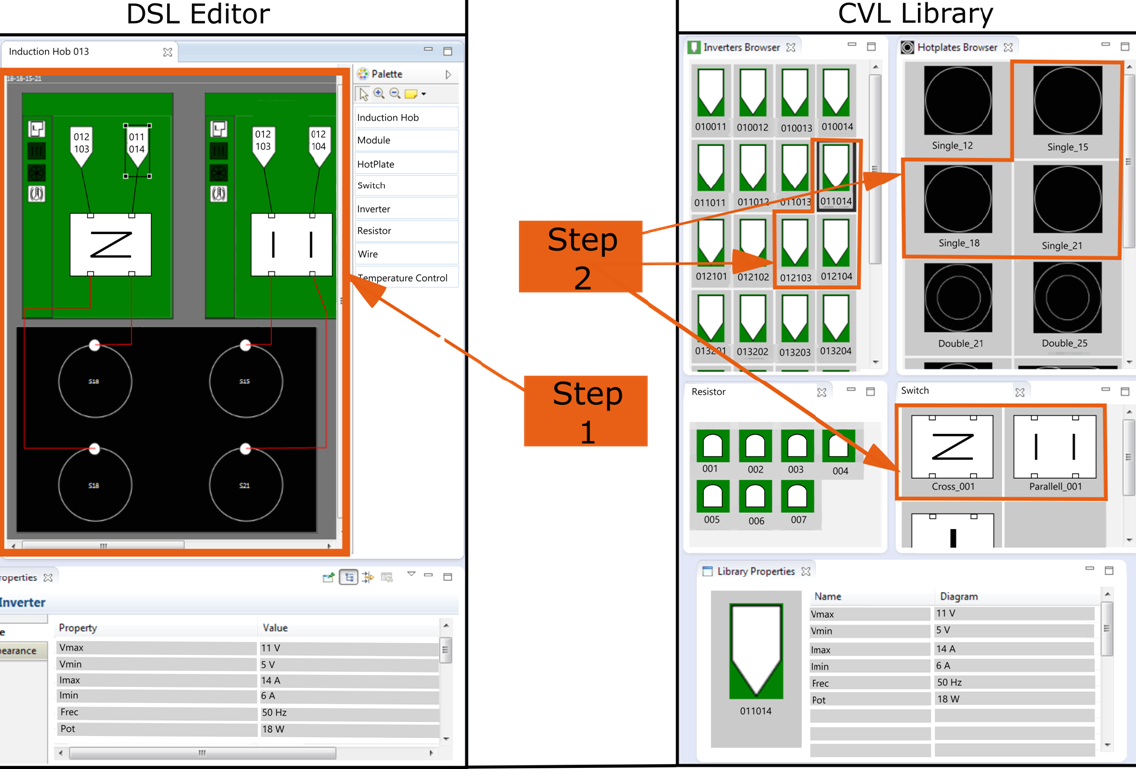
Figure 10. Visualization